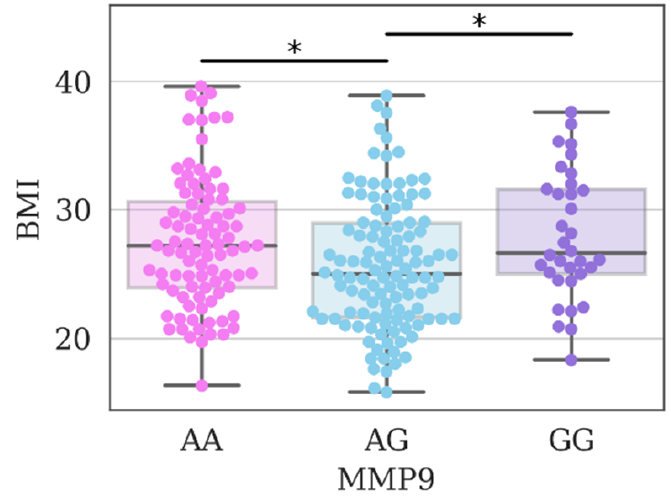
Figure 2. Body mass index values in the study group of individuals depending on the genotypes of polymorphism rs17576 of the MMP9 gene; *—differences were considered significant at a corrected p -value ( p ) < 0.05 (Kruskal–Wallis test, post-hoc Dunn’s test 2-stage FDR